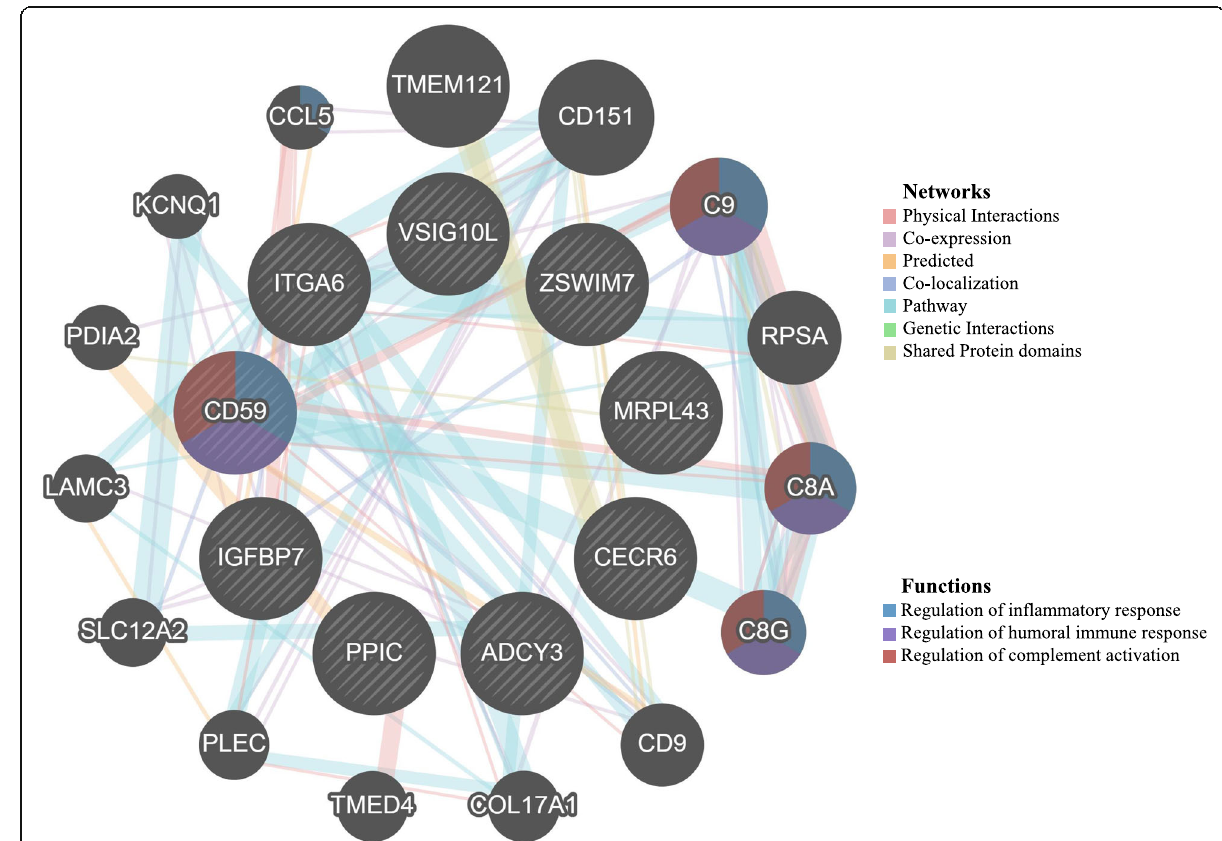
Fig. 4 Construction of a gene-gene network using the most significantly upregulated genes (fold change > 1.24 and p -value < 0.05). Black circles with white stripes (inside circle) indicate genes that were entered as query terms, while black circles indicate the associated genes. The size of the circle corresponds with the number of correlations with other genes in the